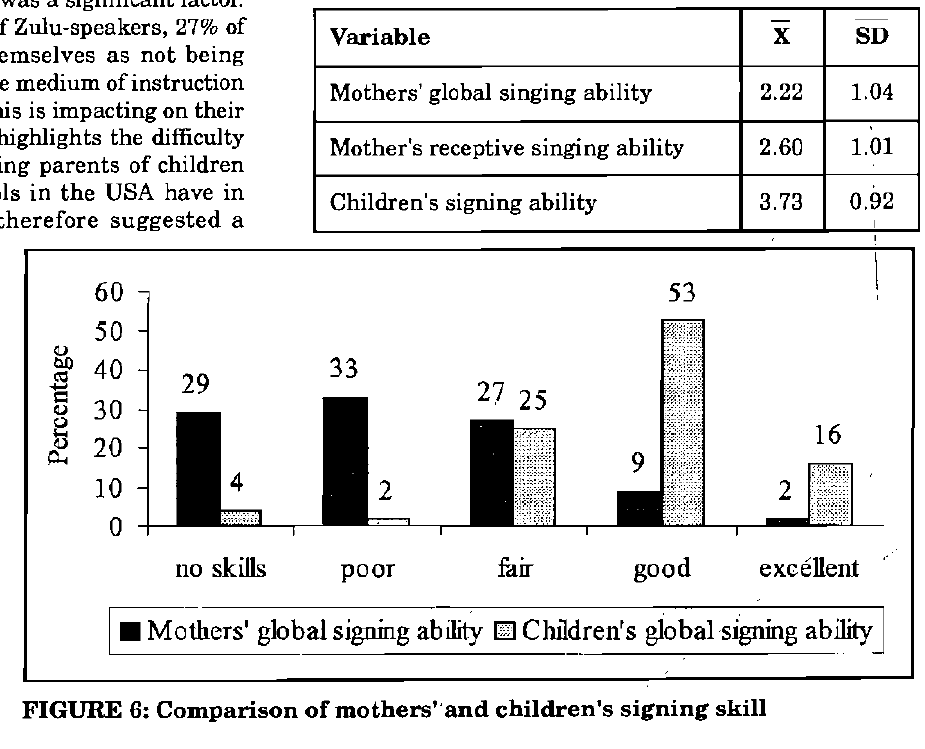
FIGURE 6: Comparison of mothers' and children's signing